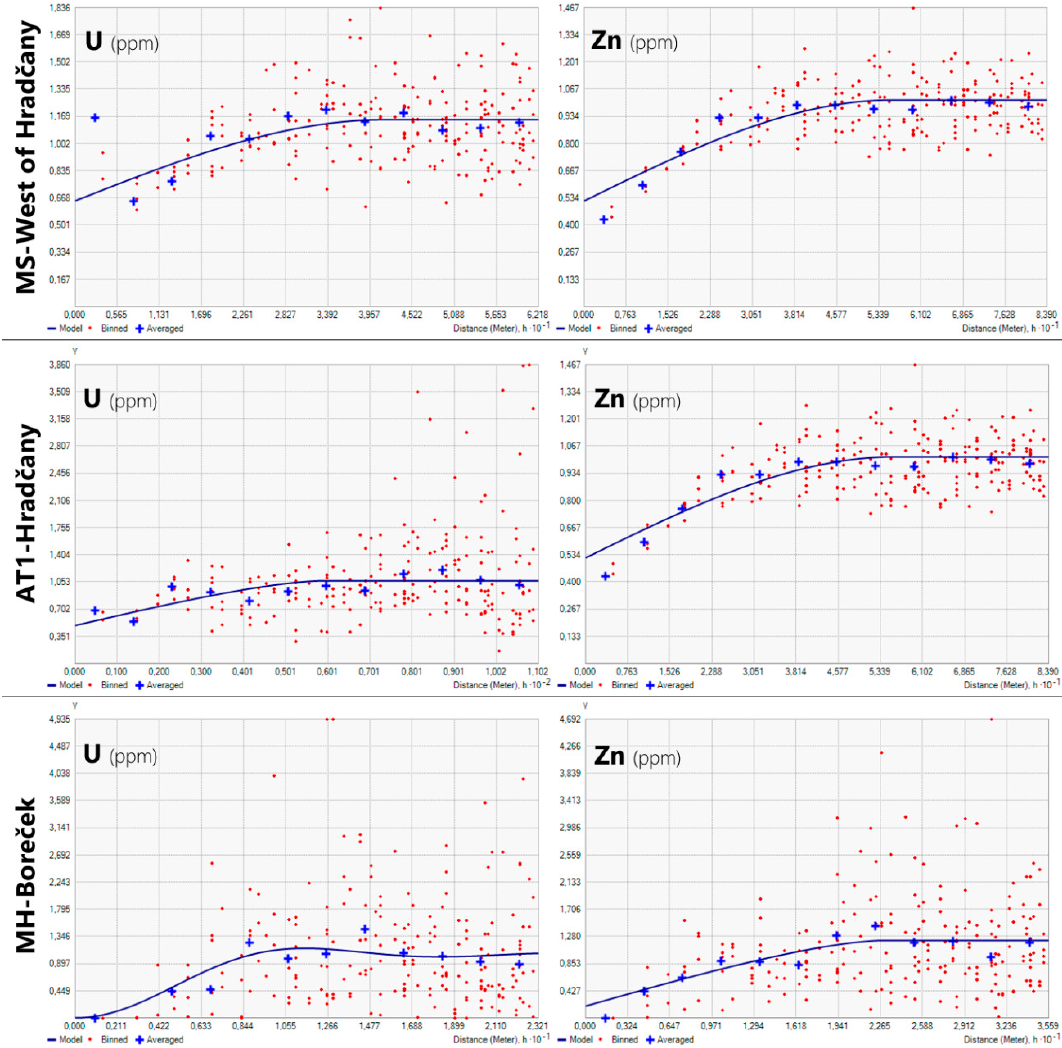
Figure 4. Estimated optimal variogram functions (blue lines) for U (left panels) and Zn (right panels) in the study areas.